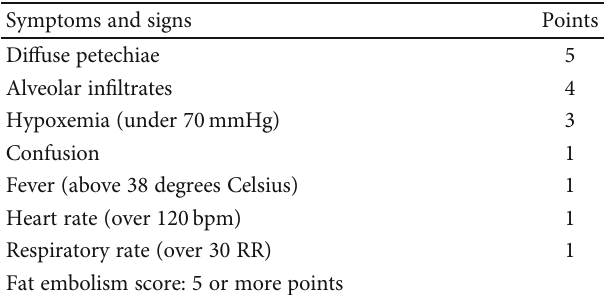
Table 1: Schonfeld ’ s Fat Embolism Score Index [5]. Symptoms and